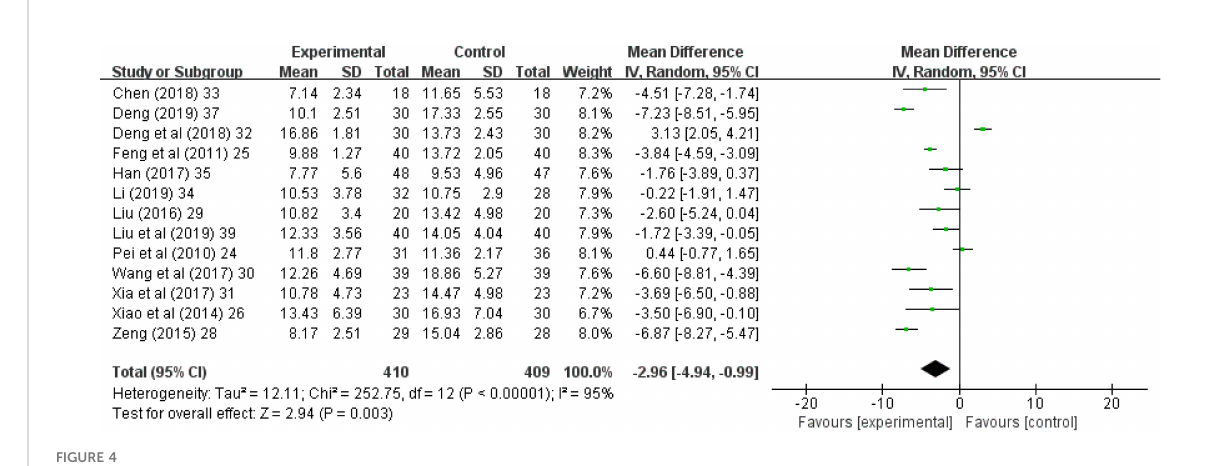
FIGURE 4 Forest chart of Hamilton Rating Scale for Depression. CI, Con fi dence Interval; IV, Information Value.